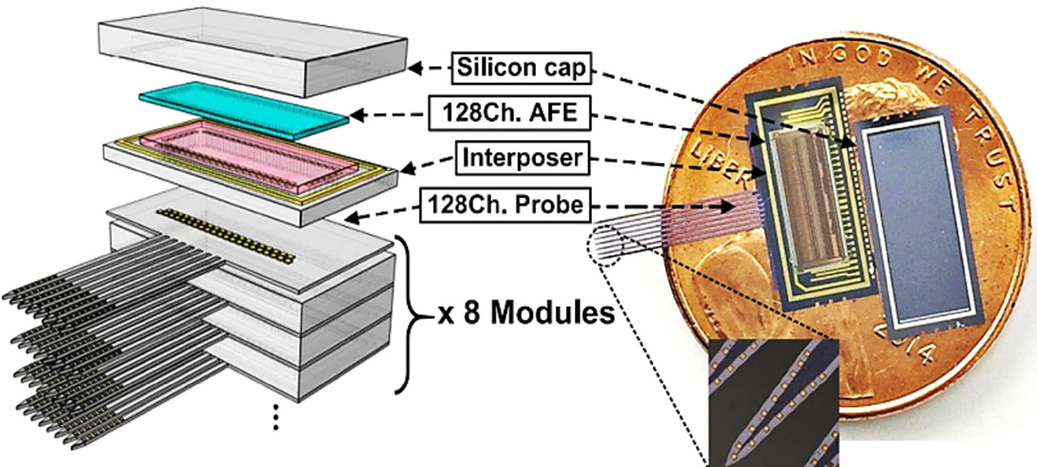
Figure 7. Proposed IC in [114]: Conceptual diagram of a 1024-channel parallel-recording platform assembled with the proposed 128-channel AFEs, interposers, silicon caps, and 128-channel multi- shank probes, and a photograph of the fabricated module on the top of a U.S. penny (Reproduced with permission from [114], IEEE, 2018).